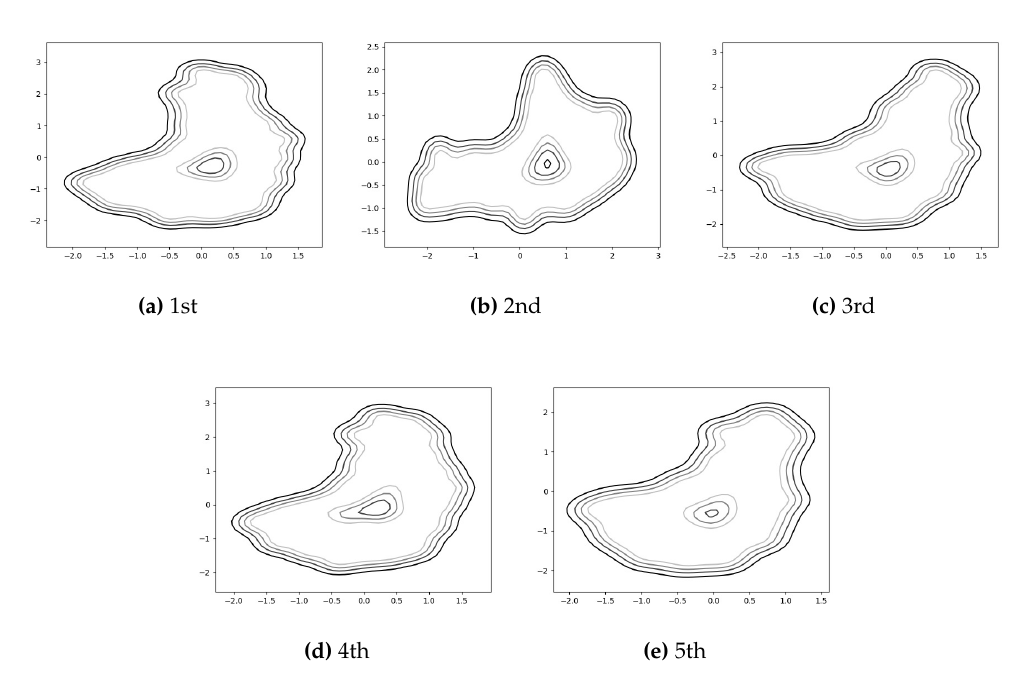
Figure 7. GP-based novelty detection results for a subject with the five-fold cross validation.